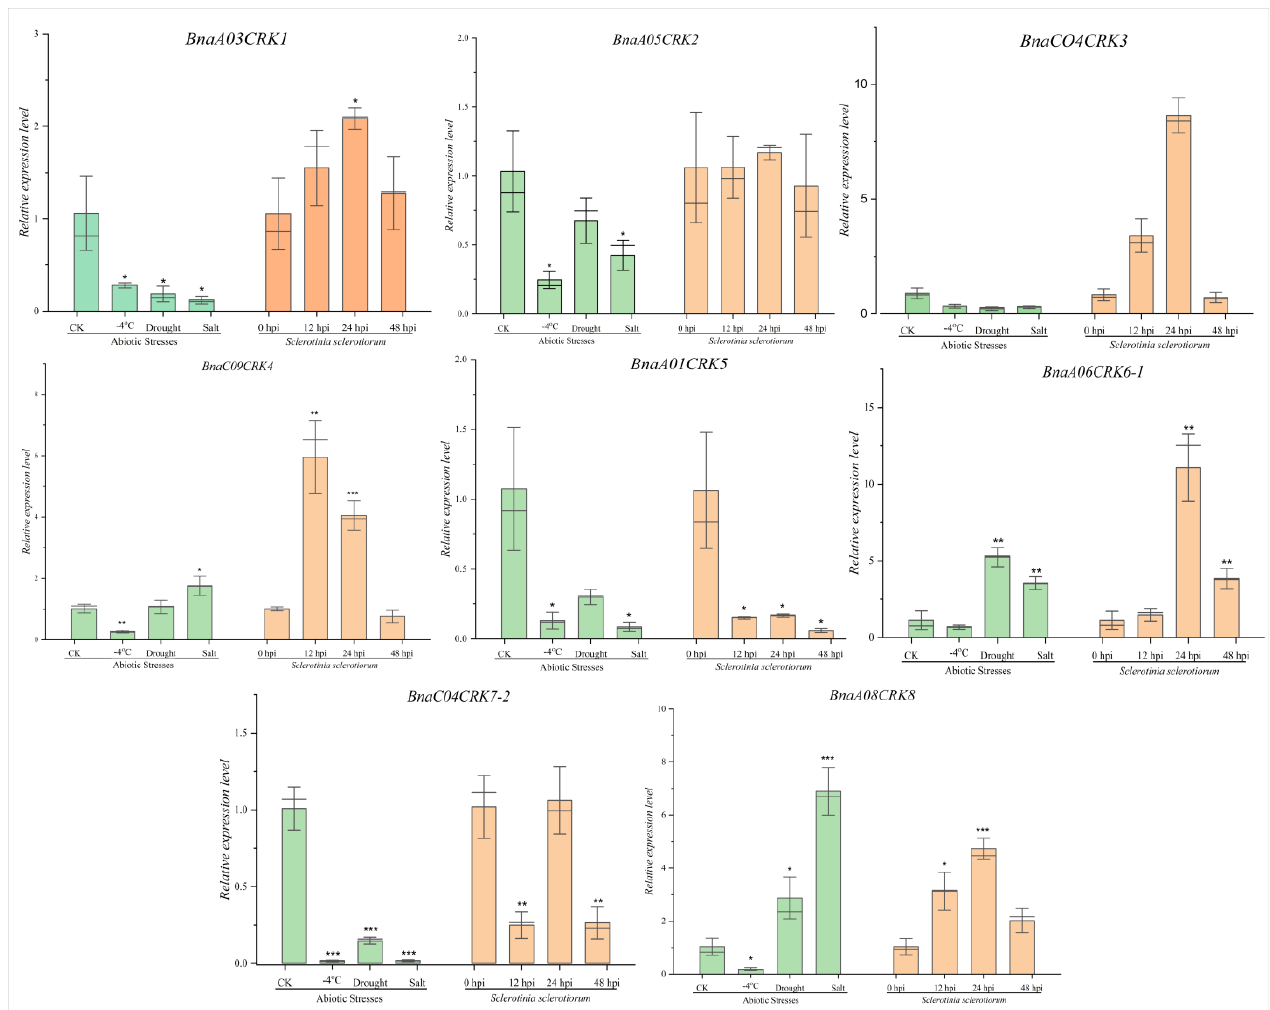
Figure 9. Relative expression pattern analysis of BnaCRKs in response to multiple stresses. CK represents the control group. The B. napus Actin (gene ID: XM013858992) was used to adjust the expression level of the selected BnaCRKs . Expression data from three independent biological replicates with standard error ± (SE) were displayed on the y -axis, and the x -axis represents the different treatments (mentioned in Table S9.2). Significant differences are denoted by asterisks on the vertical bar at * p < 0.05, ** p < 0.01, *** p < 0.001.